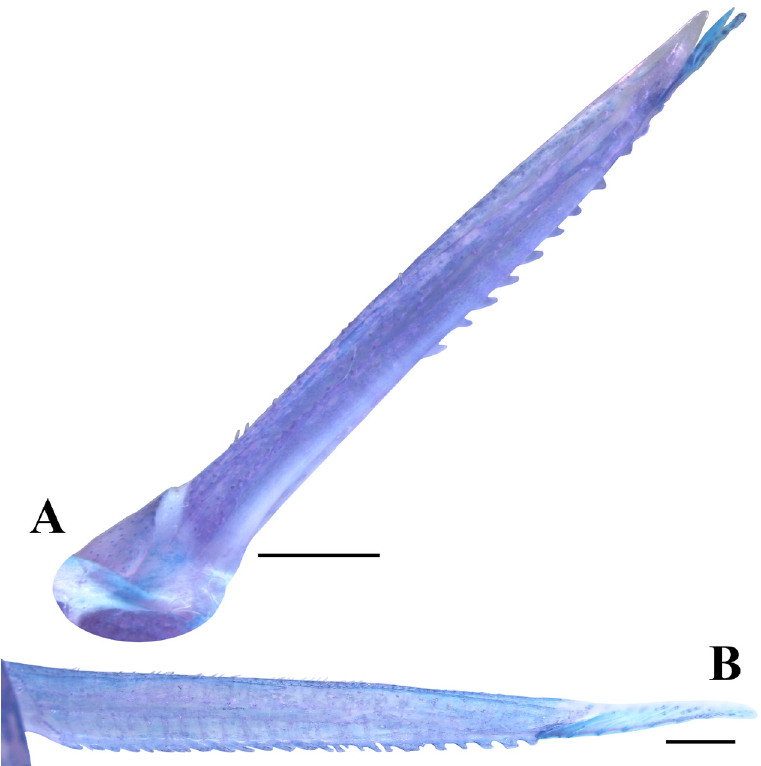
FIGURE 6 | Lateral view of ( A ) the dorsal-fin spine (38.2 mm SL) and dorsal view of ( B ) the right pectoral-fin spine (47.8 mm SL), showing the serration patterns in c&s paratypes of Corydoras maclurei (CITL 430). Scale bars = 1